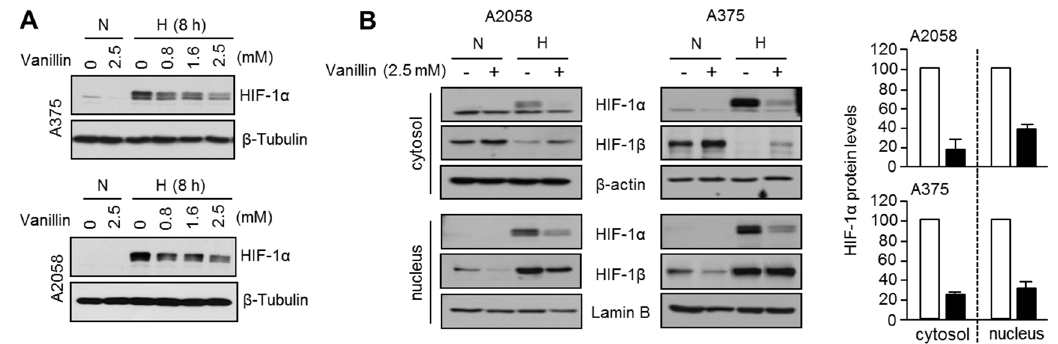
Figure 2. Vanillin decreases hypoxia-inducible factor (HIF)-1 α protein levels upon hypoxia. ( A ) Vanillin suppresses hypoxia-induced HIF-1 α protein levels. Cells were incubated in the absence or presence of vanillin for 8 h under normoxic or hypoxic condition. HIF-1 α protein levels were measured by immunoblotting using anti-HIF-1 α antibody; ( B ) Nuclear HIF-1 α protein was decreased by vanillin treatment under hypoxia. Protein levels were quantified using Image J 1.49v software (National Institutes of Health, Bethesda, MD, USA). Values represent the mean ± standard deviations of three independent experiments performed.